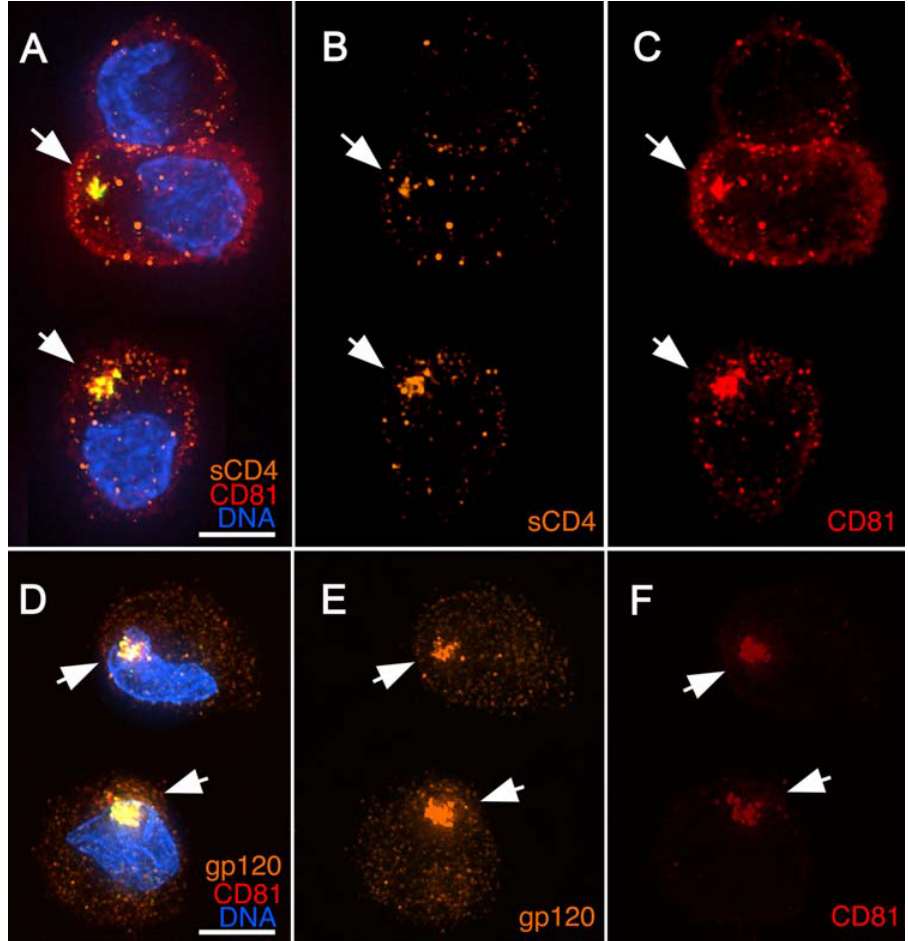
Figure 6. Internalized HIV is accessible to surface applied HIV-specific inhibitory antibodies. (A–F) Mature MDDCs were pulsed with HxB2 pseudotyped GFP-Vpr HIV (green) for 1 h, washed, and cultured for 1 h at 37 u C. Cells were then placed on ice and incubated for 30 min with (A–C) CD4-hIgG fusion protein or (D–F) 2G12 anti-HIV Env (gp120), a human mAb. Cells were washed at 4 u C, fixed, and stained for human IgG (orange) and CD81 (red); nuclei were stained with Hoechst (blue). Images are 3-D reconstructions of whole-cell volumes. Arrows denote concentrated HIV co- localized with the surface applied probes and CD81. Bars, 5 m .